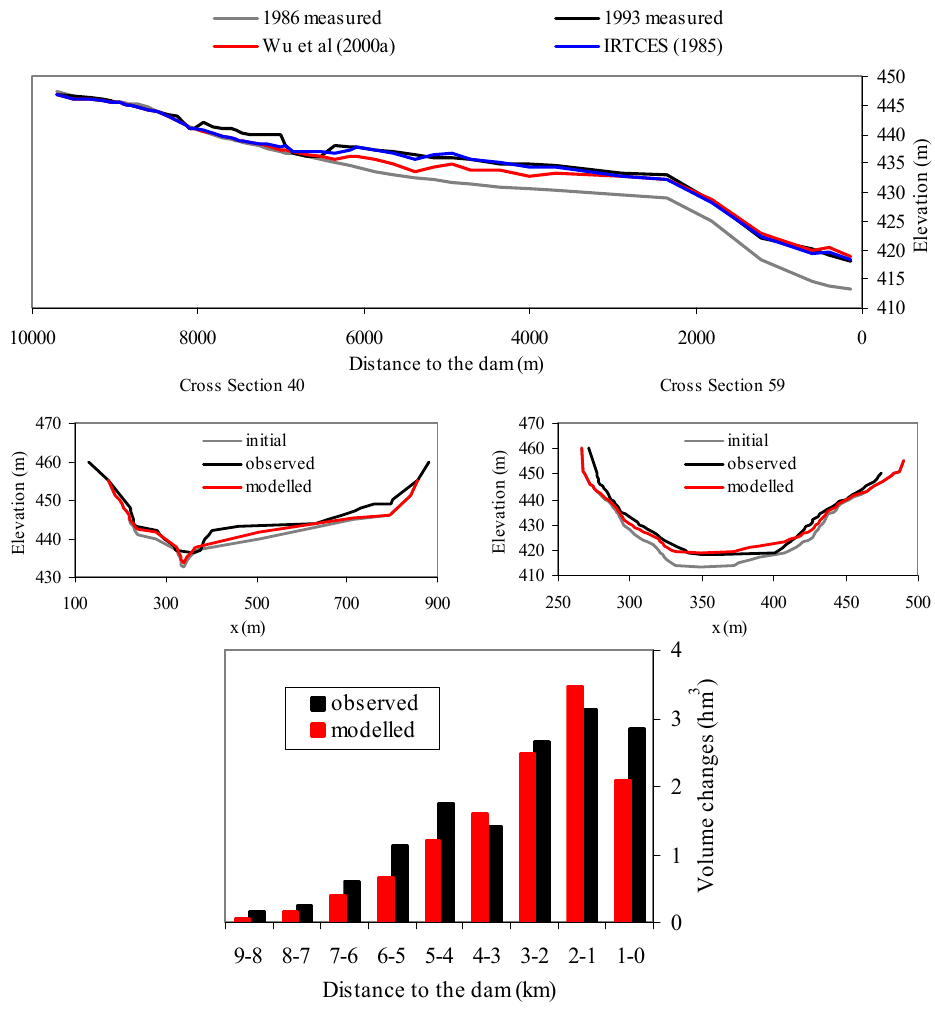
Fig. 8. Measured and simulated bed elevation changes for the simulation period 1986–1993 (a) along the longitudinal profile of the Barasona Reservoir for the Wu et al. (2000) and Tsinghua University (IRTCES, 1985) formulas; (b) at two different cross-sections for the Wu et Figure 8: Measured and simulated bed elevation changes for the simulation period 1986 – al. (2000) formula; (c) Sediment volume changes along the longitudinal profile of the reservoir. 1993 a) along the longitudinal profile of the Barasona Reservoir for the Wu et al. Figure 8: Measured and simulated bed elevation changes for the simulation period 1986 – (2000) and Tsinghua University (IRTCES, 1985) formulas; b) at two different Table 8. Simulated life expectancy of the Barasona reservoir for four different management 1993 a) along the longitudinal profile of the Barasona Reservoir for the Wu et al. cross-sections for the Wu et al. formula; c) Sediment volume changes along the Figure 8: Measured and simulated bed elevation changes for the simulation period 1986 – (2000) and Tsinghua University (IRTCES, 1985) formulas; b) at two different longitudinal profile of the reservoir 1993 a) along the longitudinal profile of the Barasona Reservoir for the Wu et al. cross-sections for the Wu et al. formula; c) Sediment volume changes along the (2000) and Tsinghua University (IRTCES, 1985) formulas; b) at two different cross-sections for the Wu et al. formula; c) Sediment volume changes along the longitudinal profile of the reservoir